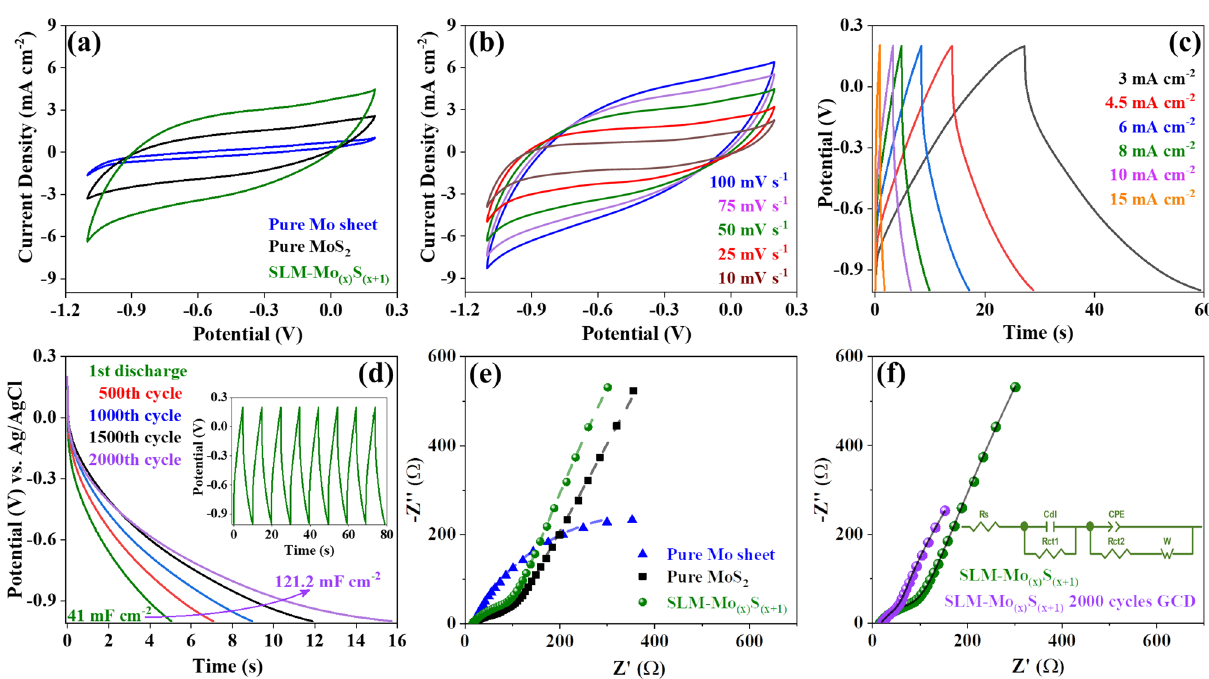
Figure 4. Electrochemical characterization in a 0.5 M Na 2 SO 4 : (a) CV curves of pure Mo sheet, pure MoS 2 , and SLM-Mo (x) S (x+1) by using a scan rate of 50 mV s -1 , (b) cyclic voltammograms for different scan rates from 10 to 100 mV s −1 , (c) GCD curves for different current densities from 3 to 15 mA cm −2 , (d) discharge retention stability after 500, 1000, 1500, and 2000 cycles of GCD at a current density of 8 mA cm −2 , and (e) Nyquist plot of pure Mo sheet, pure MoS 2 , and SLM-Mo (x) S (x+1) in the frequency range between 10 –1 Hz to 100 kHz, (f) Nyquist plot of SLM-Mo (x) S (x+1) in the frequency range between 10 –1 Hz to 100 kHz before and after 2000 cycles of GCD at a current density of 8 mA cm −2